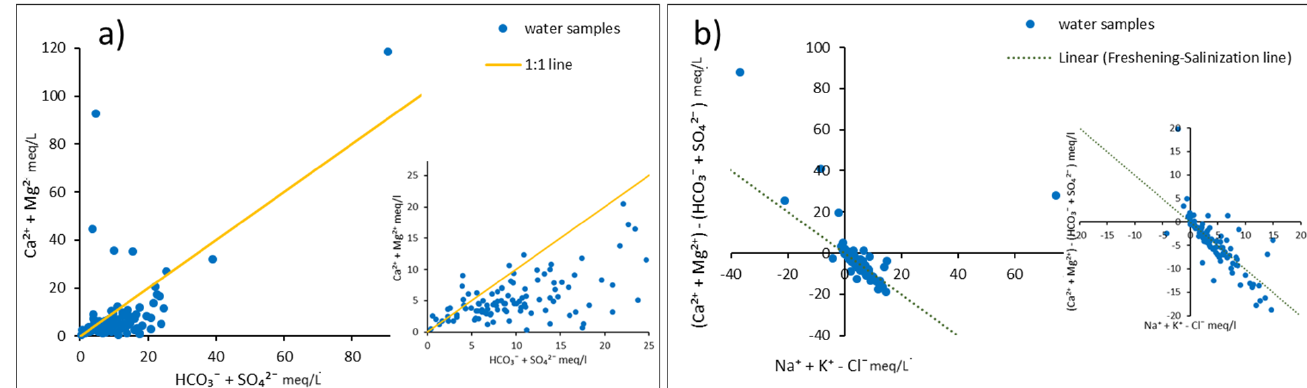
Figure 9. Relationship between (HCO 3 + SO 4 ) versus (Ca + Mg) ( a ) and (Ca + Mg − SO 4 − HCO 3 ) versus (Na + K − Cl) ( b ).